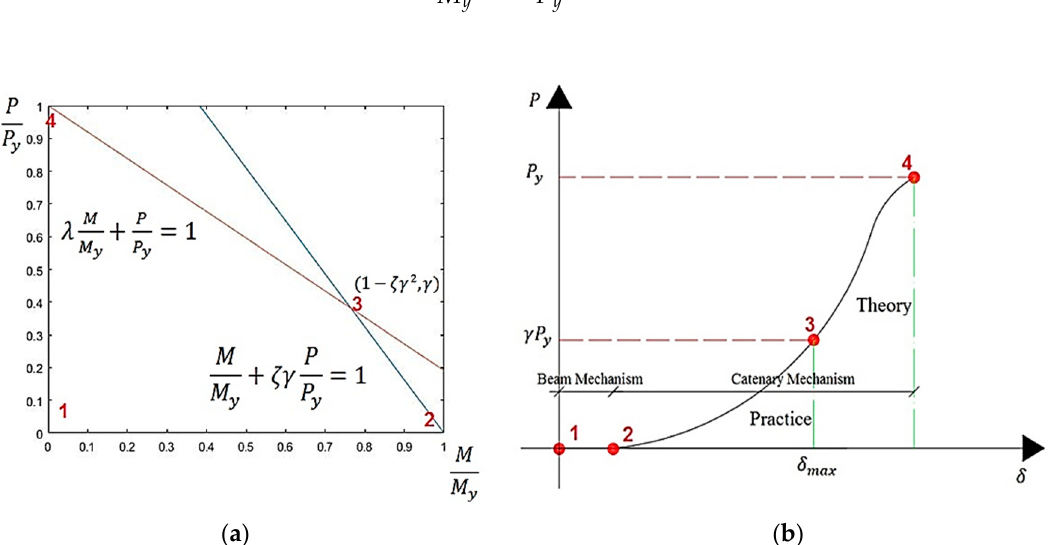
Figure 8. ( a ) Plastic interaction between bending moment and tensile force, and ( b ) beam axial force versus mid-span